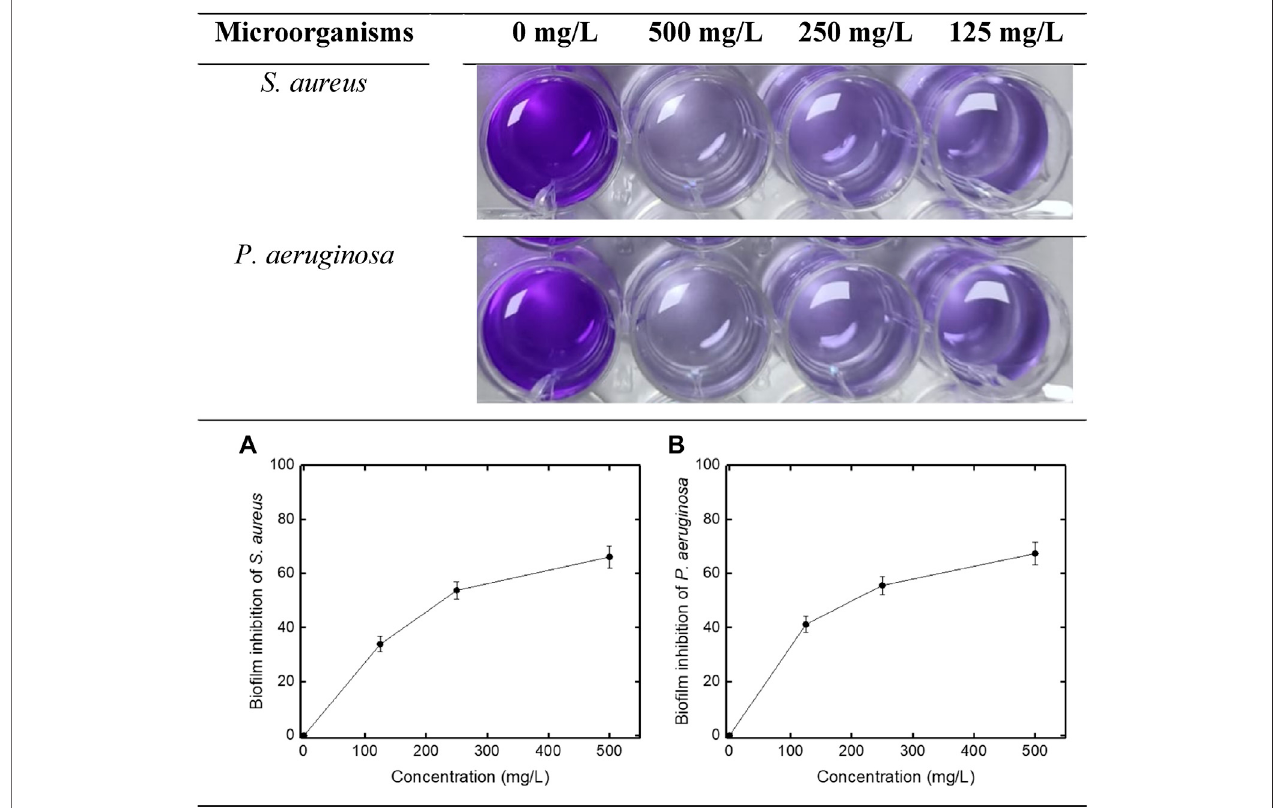
FIGURE 7 | Bio fi lm